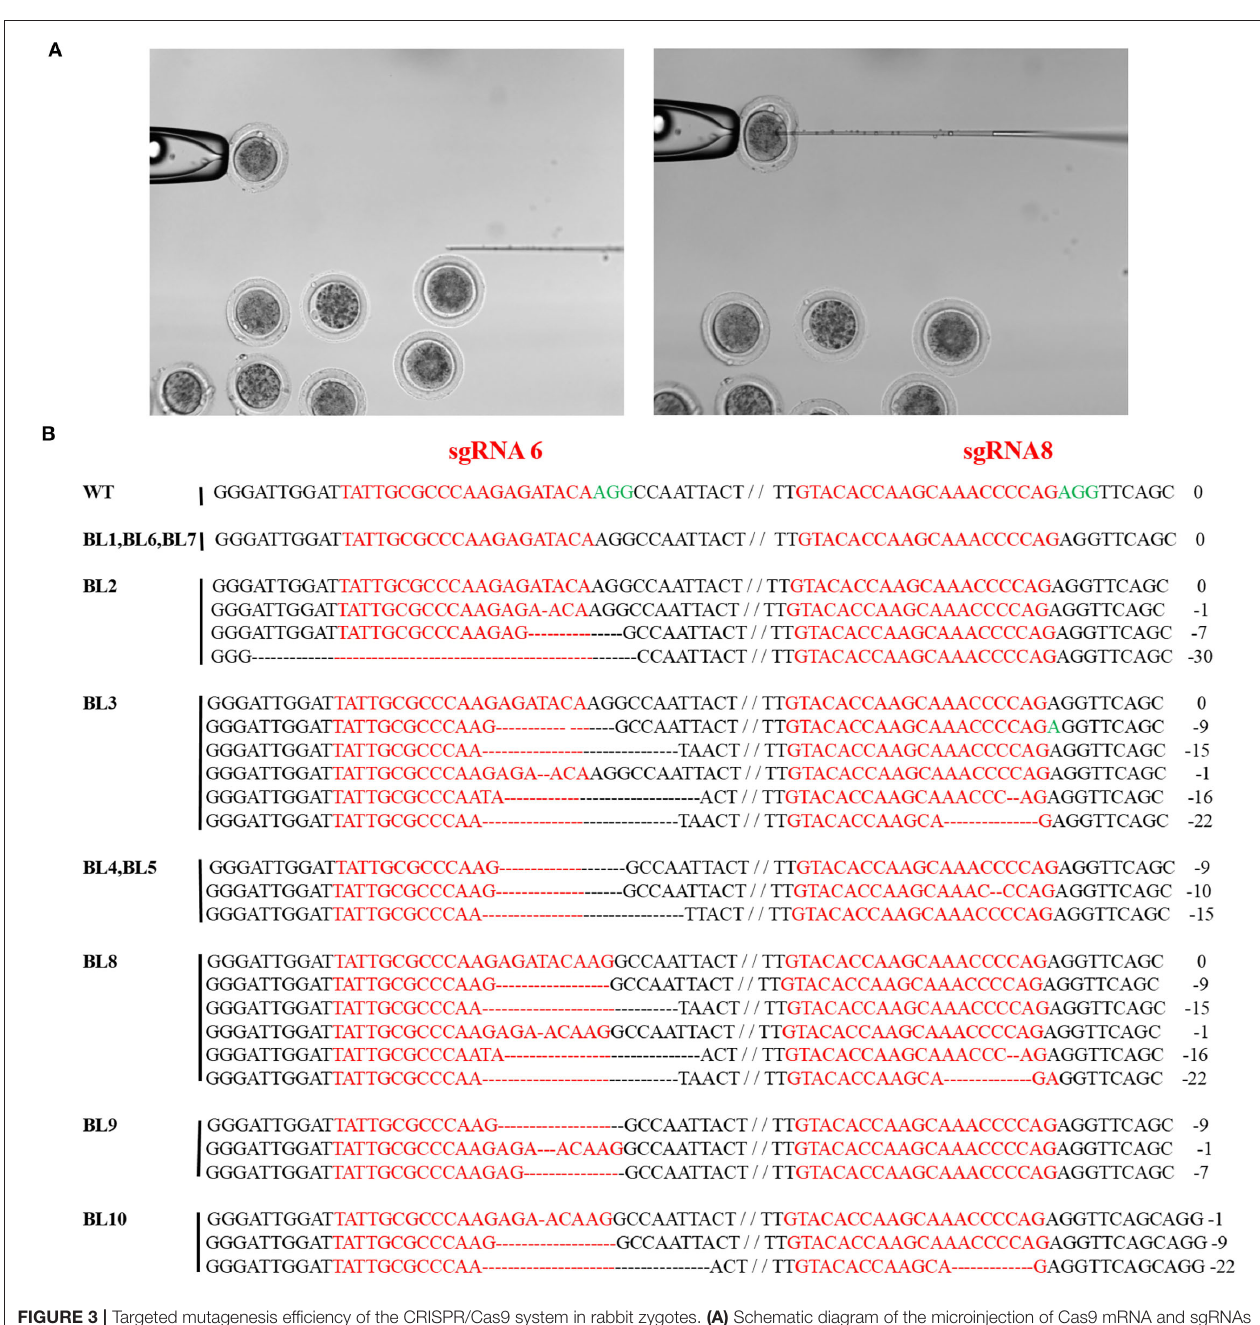
FIGURE 3 | Targeted mutagenesis efficiency of the CRISPR/Cas9 system in rabbit zygotes. (A) Schematic diagram of the microinjection of Cas9 mRNA and sgRNAs into rabbit zygotes. (B) BL1-BL7 represent different blastocysts used in this study. Sanger sequence analysis of zygotes. zygotes edited were named on the left. PAM sequence is marked in green. The sgRNAs sequence is marked in red. The numbers on the right indicated the type of mutation, with “-” represents deletion of the given number of nucleotides.